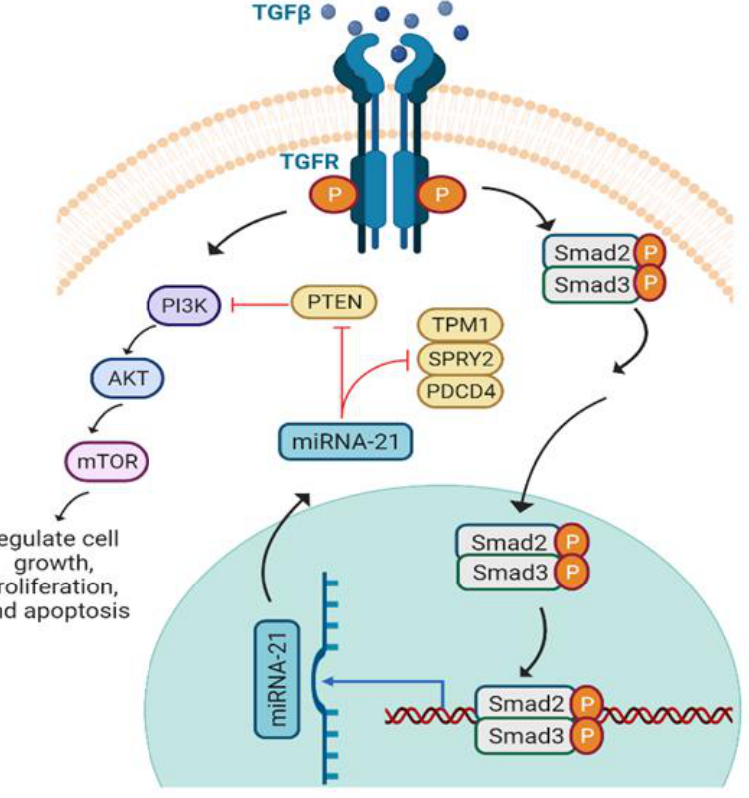
Figure 10. mi-RNA-21 signaling and axonal growth. Following trauma, TGF- β1 binds to particular TGF receptors and stimulates PI3K/AKT/mTOR signalling as well as phosphorylating and translocating SMAD2 and SMAD3 into the nucleus where it modulates miR-21 expression and allows it to move to the cytoplasm and inhibits growth suppressors such as PTEN, Pdcd4, Spry2, and Tpm1 to regulate activation of astrocytes and axonal growth. TGF β : transforming growth factor; TGFR: transforming growth factor receptors; Smad; PI3K: phosphatidylinositol-3-kinase; PTEN: phosphatase and tensin homolog; AKT: protein kinase B; mTOR: mammalian target of rapamycin; Pdcd4: programmed cell death 4 gene; Tpm1: tropomyosin 1; Spry2: sprouty RTK signalling antagonist 2.